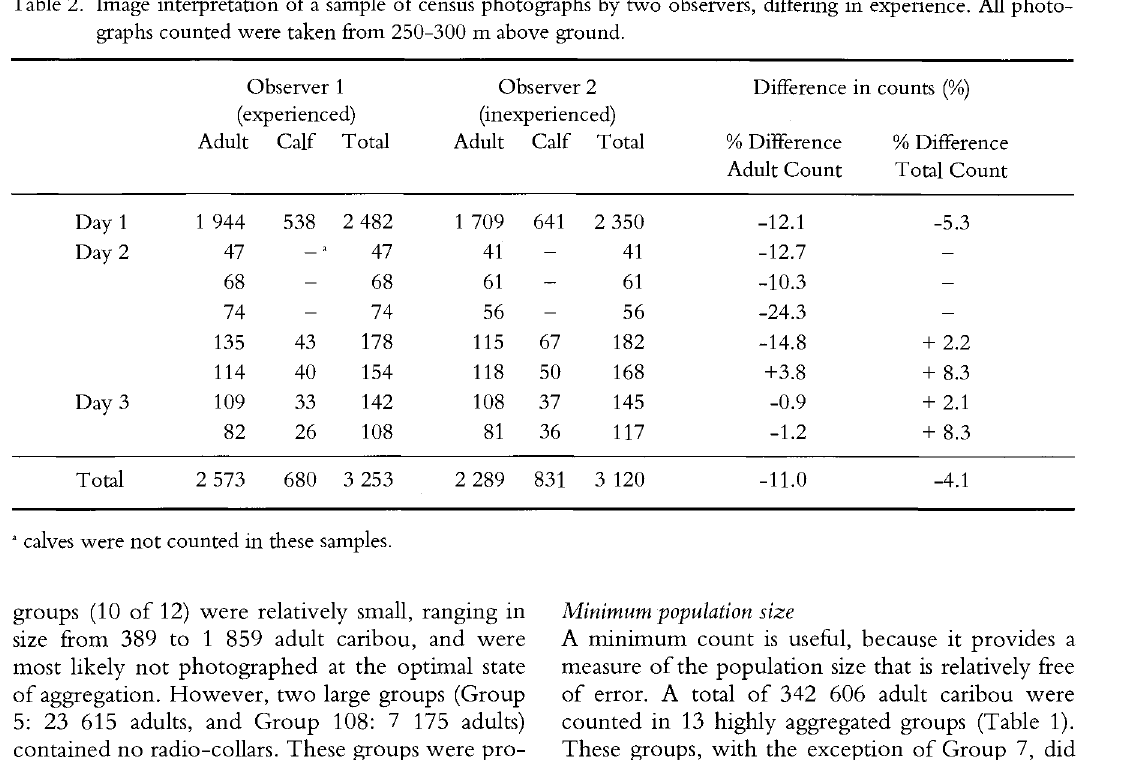
Table 2. Image interpretation of a sample of census photographs by two observers, differing in experience. All photo graphs counted were taken from 250-300 m above